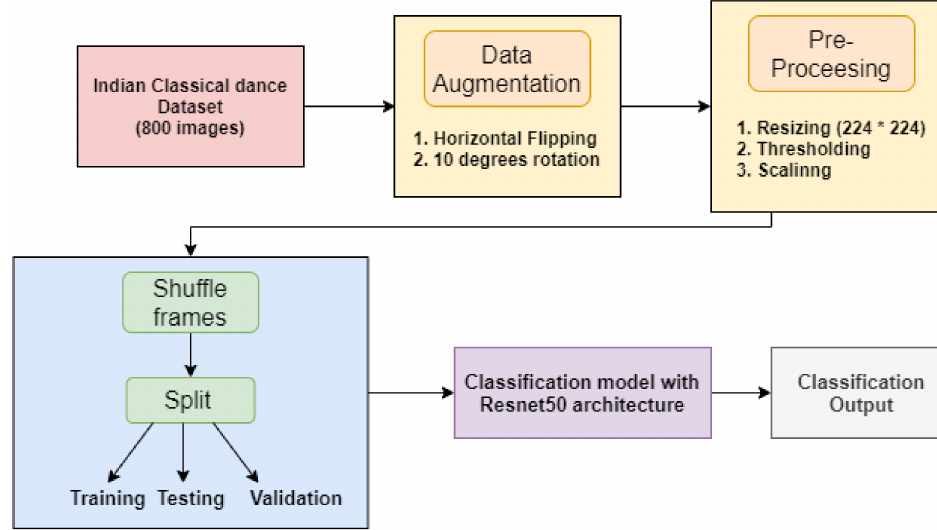
Figure 1. Proposed methodology.